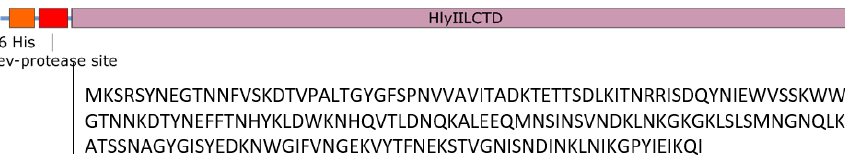
Figure 7. Amino acid sequence of HlyIILCTD from B. cereus ATCC 14579 (M225-I412, according to the full length of the HlyII toxin [7]).